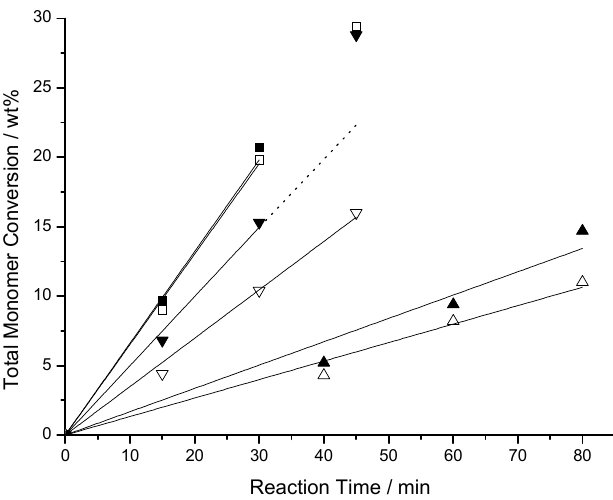
Figure 1. Time conversion plots of binary copolymerization experiments with the comonomer pairs BMA/MAH ( (cid:4) : f MAH = 0.35, (cid:3) : f MAH = 0.60), F8H2MA/MAH ( (cid:78) : f MAH = 0.3, (cid:52) : f MAH = 0.6) and F8H2MA/BMA ( (cid:72) : f BMA = 0.2, (cid:53) : f BMA = 0.45). Table 3. Monomer mixture in the feed, copolymer compositions and initial weight rate of polymerization of the three monomer pairs MAH/F8H2MA, MAH/BMA and BMA/F8H2MA. Monomer 1 Monomer 2 f 1